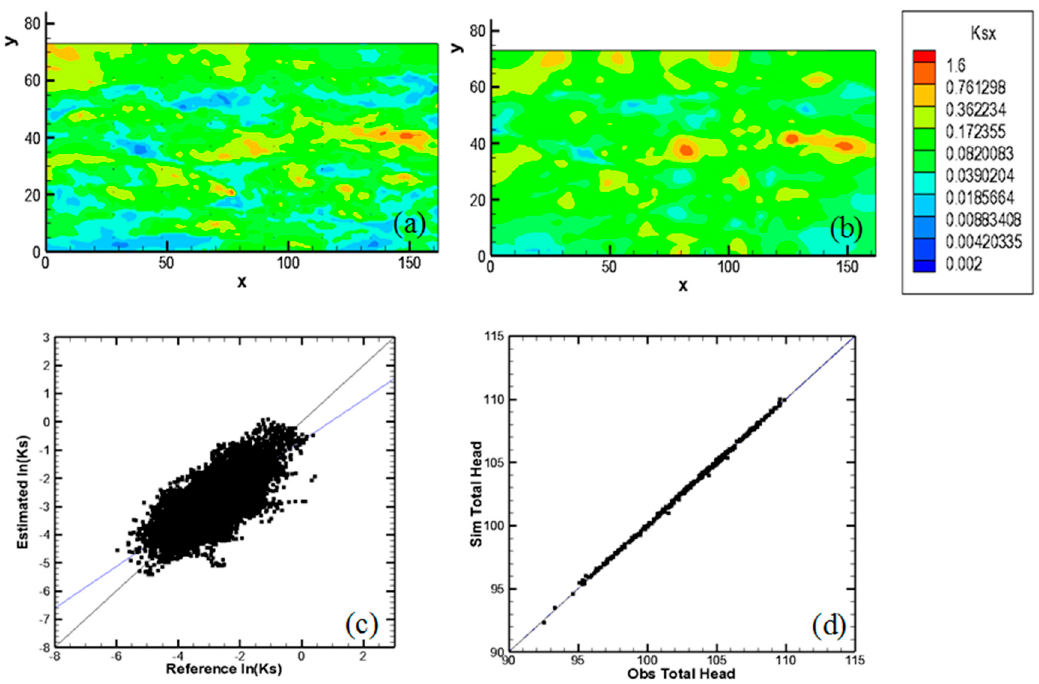
Figure 4. Spatial distribution of different K field: ( a ) the reference K field; ( b ) the hydraulic tomography (HT)-estimated K field. Scatter plots of fitting curves: ( c ) the HT-estimated LnK and ( d ) the HT-estimated head H. The units of axis are cm/s.